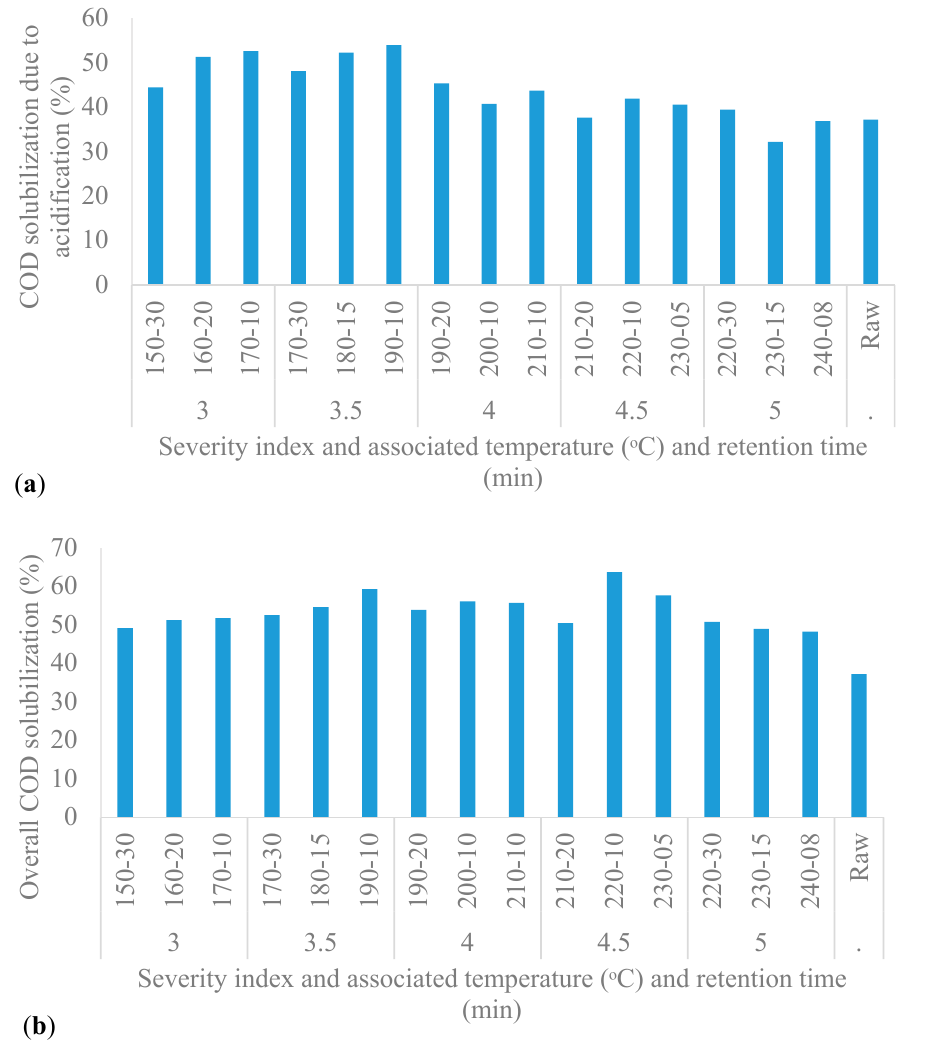
Figure 4. Effect of HTP on COD after acidification. ( a ) COD solubilization after acidification; ( b ) Overall acidification.